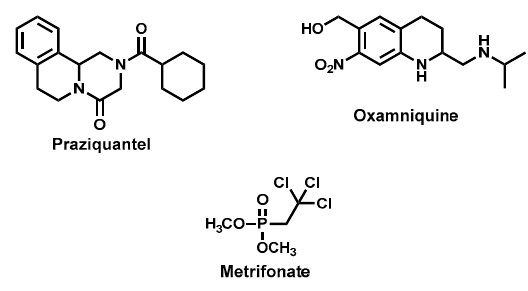
Figure 13. Clinically established antischistosomal drugs.